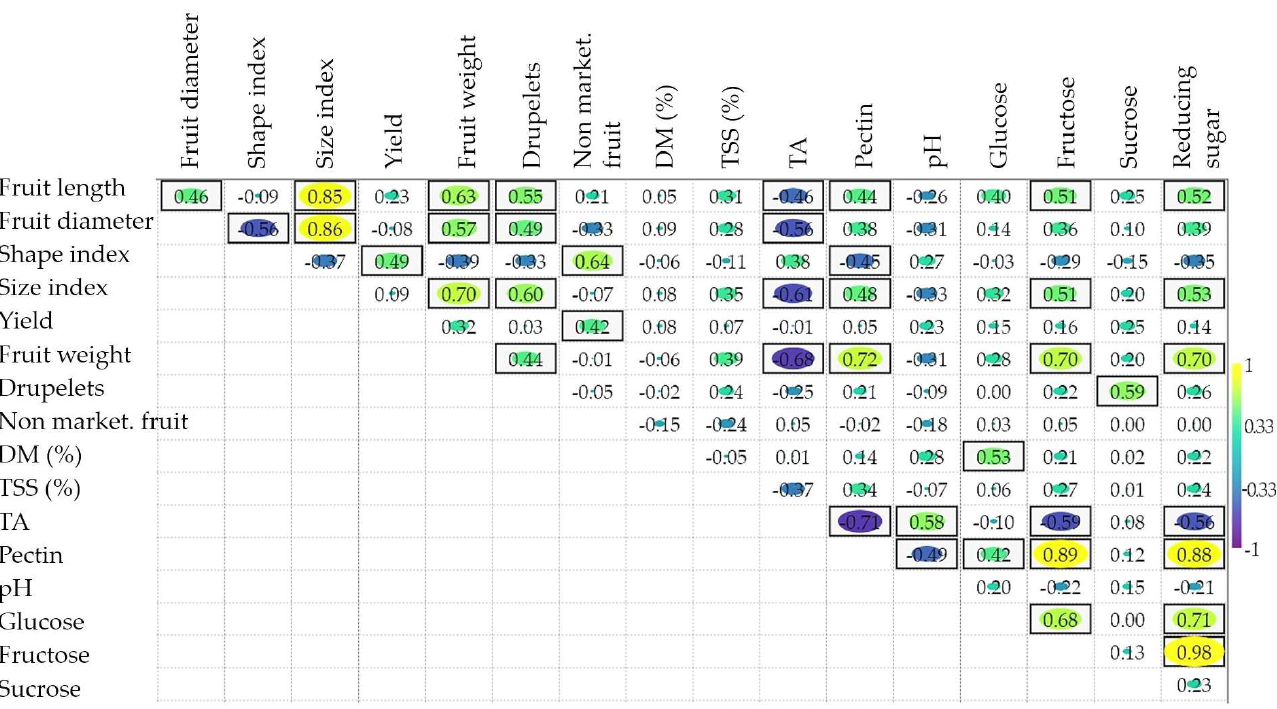
Figure 2. Pearson correlation coefficients (‘ r ’ value) between the analyzed characteristics of the 24 raspberry genotypes. DM represents dry matter, TSS represents total soluble solids, and TA represents titratable acidity. Positive correlations are displayed in yellow and green with negative correlations in blue and violet. Color intensity and the size of the circle are proportional to the correlation coefficients. The boxes with a grey border illustrate statistically assured values of ‘ r ’ at an alpha level below 0.05.